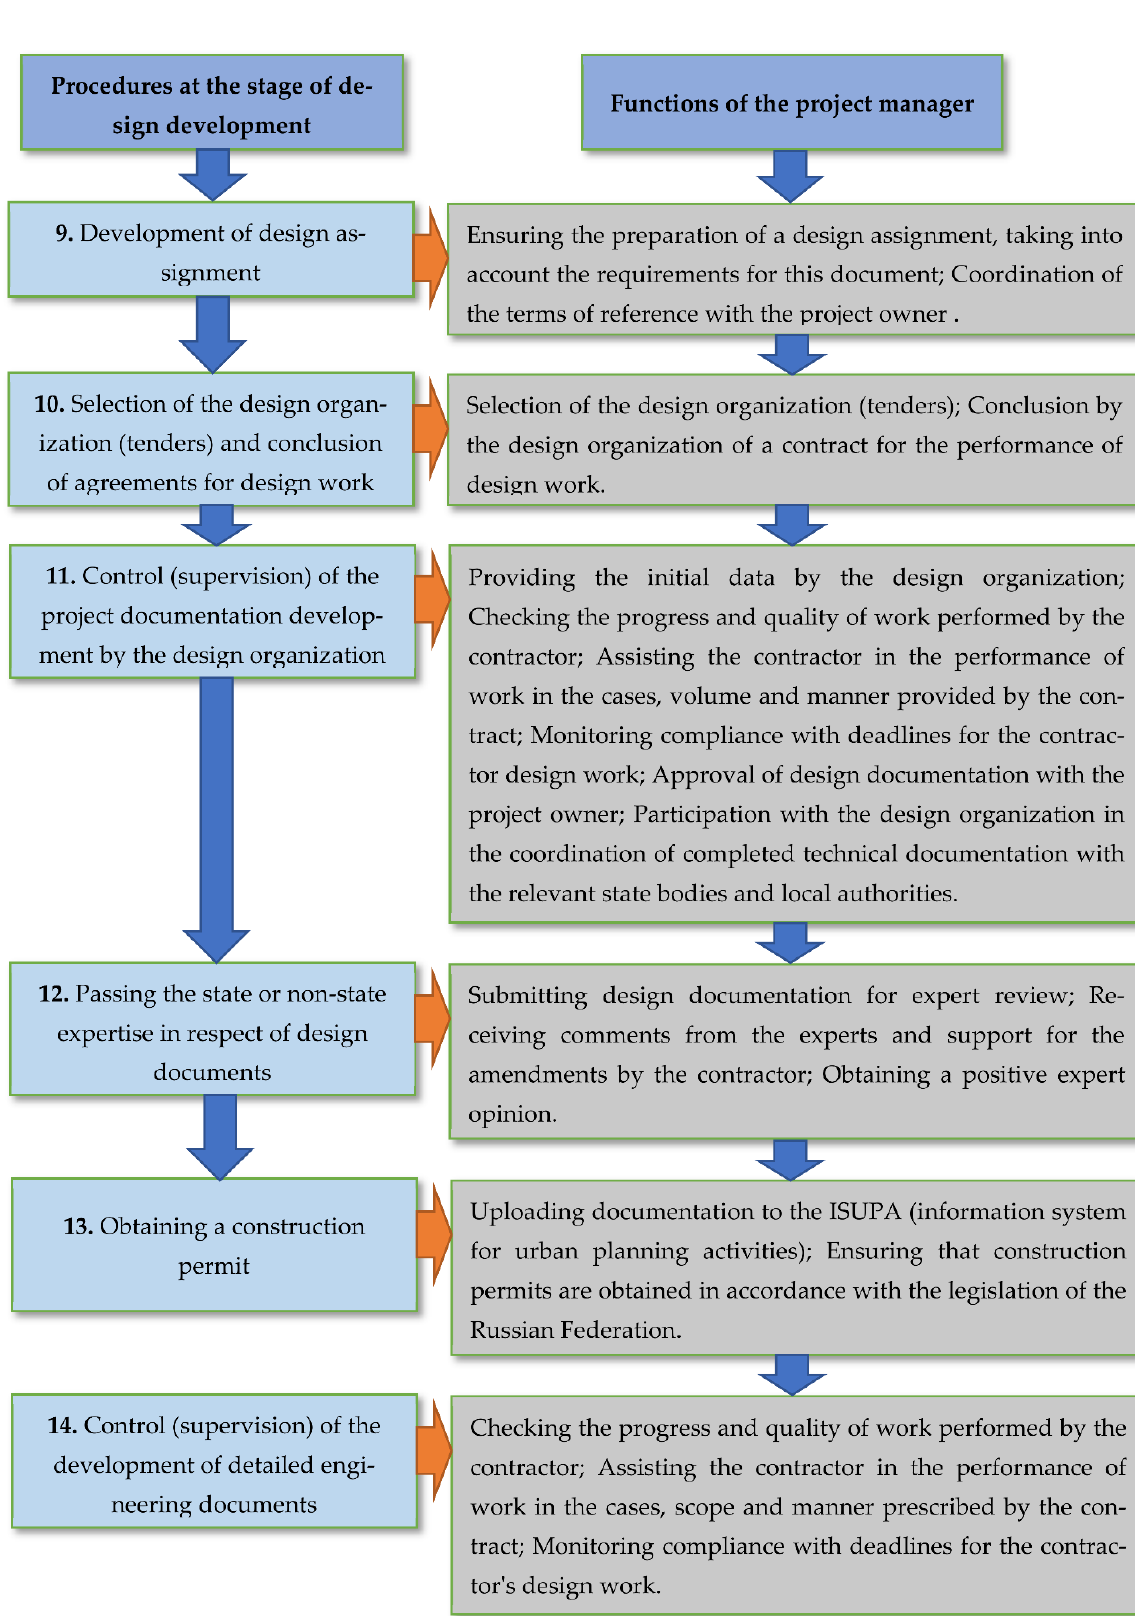
Figure 9. Consolidated procedures and functions of the project manager at the stage of design preparation for the facility to be constructed.